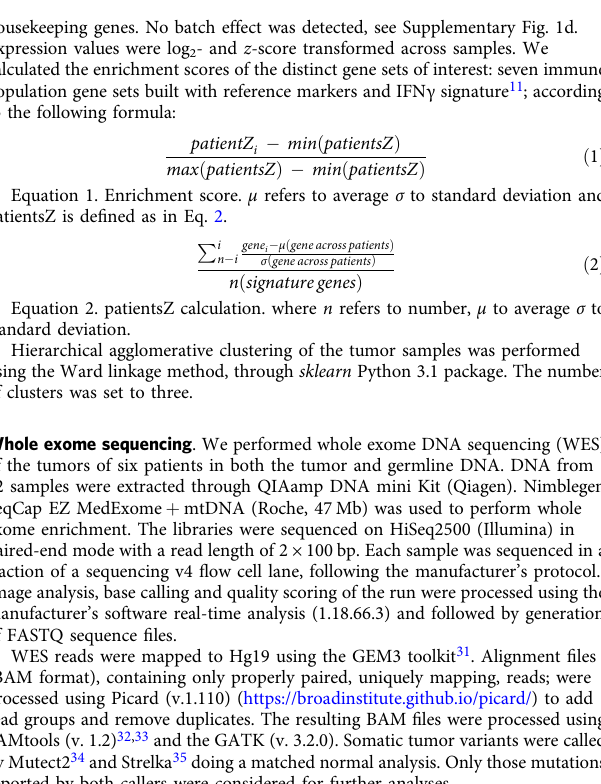
Fig. 4 T cell pro fi ling in the tumor and CSF of BrM patients. a UMAP projection of tumor-in fi ltrating and cerebrospinal fl uid (CSF) cells ( n = 6 patients, n = 16 samples, n = 15,895 cells), colored according to T cell receptor (TCR) clonotype (expanded vs. singleton). Cell size represents the degree of expansion of TCR clonotypes. A detailed UMAP projection is shown for T cell and NK and proliferating leukocyte cell clusters. Cell type clusters have been delimited and background colored (as Fig. 3c). Cytotoxic lymphocyte (CLym), cancer-associated fi broblast (CAF), tumor-associated macrophage